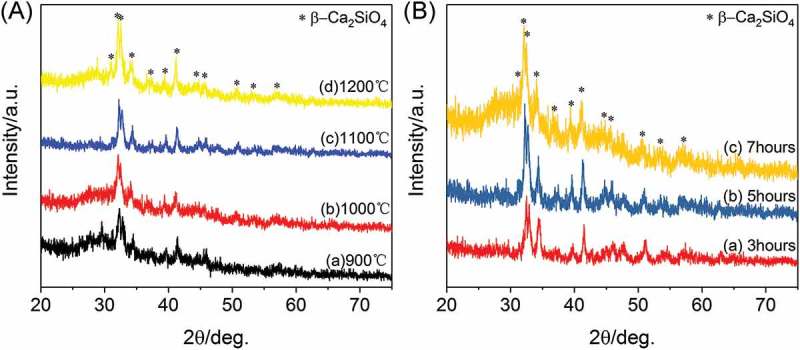
XRD patterns of (A) β-Ca2SiO4 scaffolds sintered at different temperature for 5h and (B) β-Ca2SiO4 scaffolds sintered at 1100 °C at different holding times.